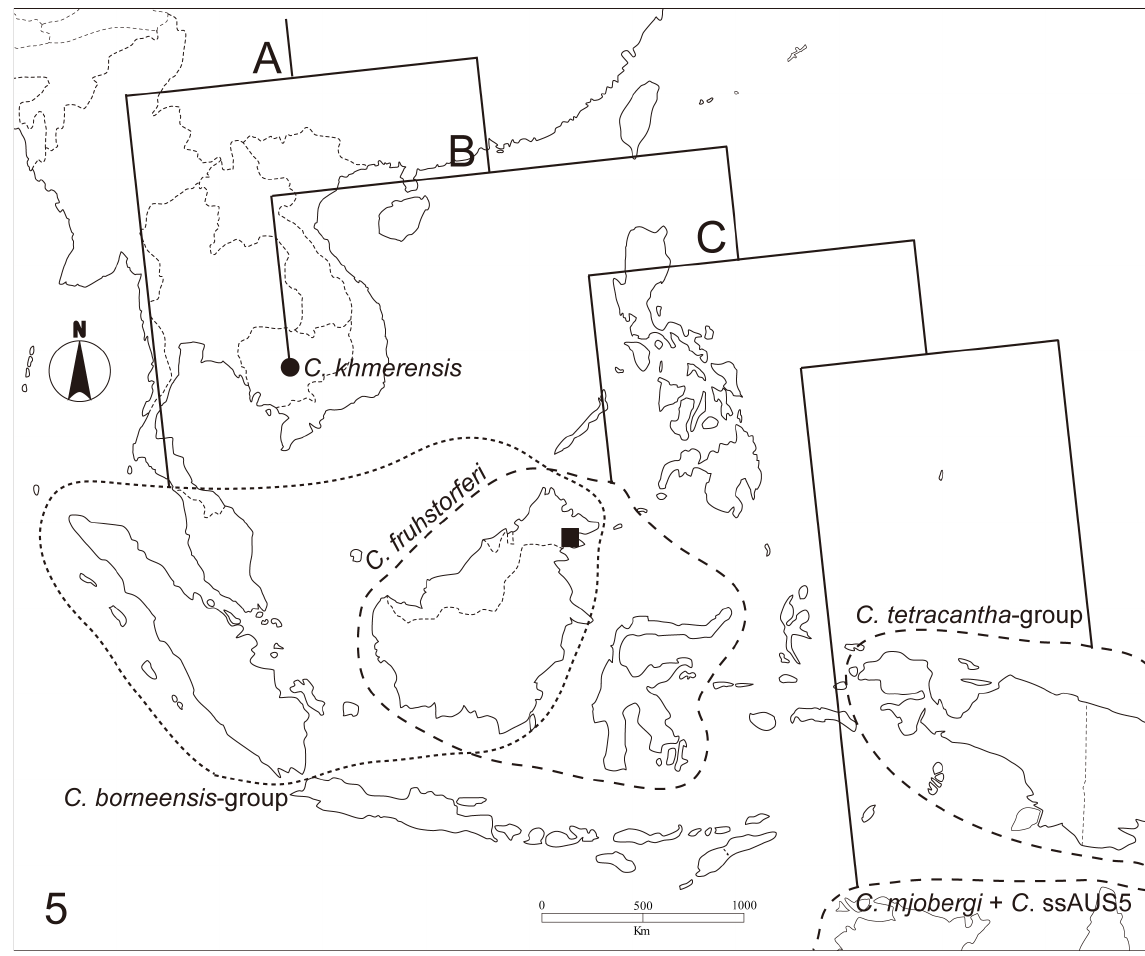
Fig. 5. Phylogeny and distribution of the Crematogaster borneensis -group, C. khmerensisi sp. nov., C . fruhstorferi , C . ssAUS5, C . mjobergi and the C . tetracantha -group. Closed circle indicates C . khmerensis sp. nov., closed square indicates C . pfeifferi sp. nov. It is noted that C . pfeifferi sp. nov. is not represented in the